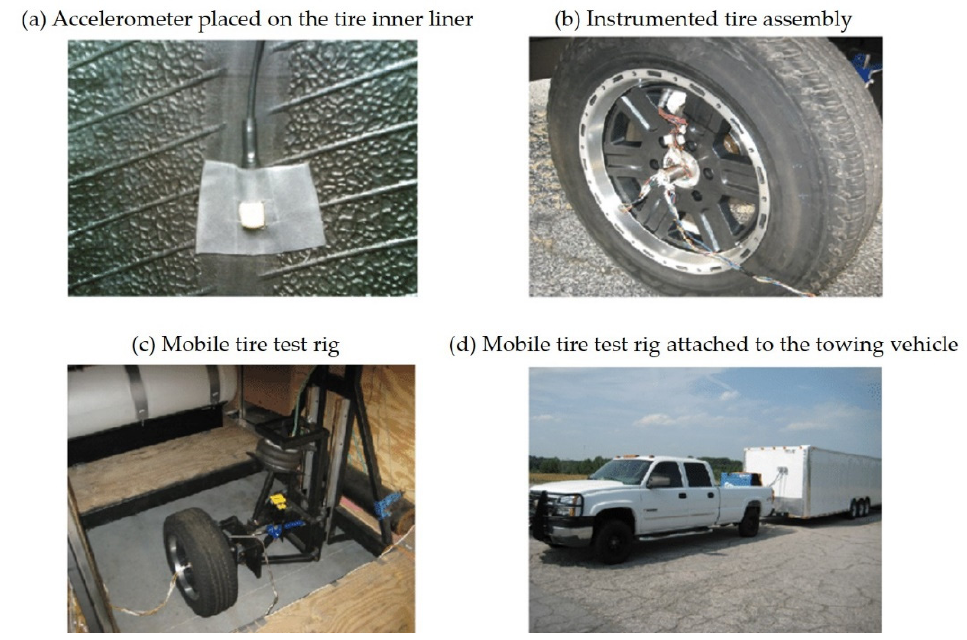
Figure 11. Full-scale application of a smart tire system and its components [87].